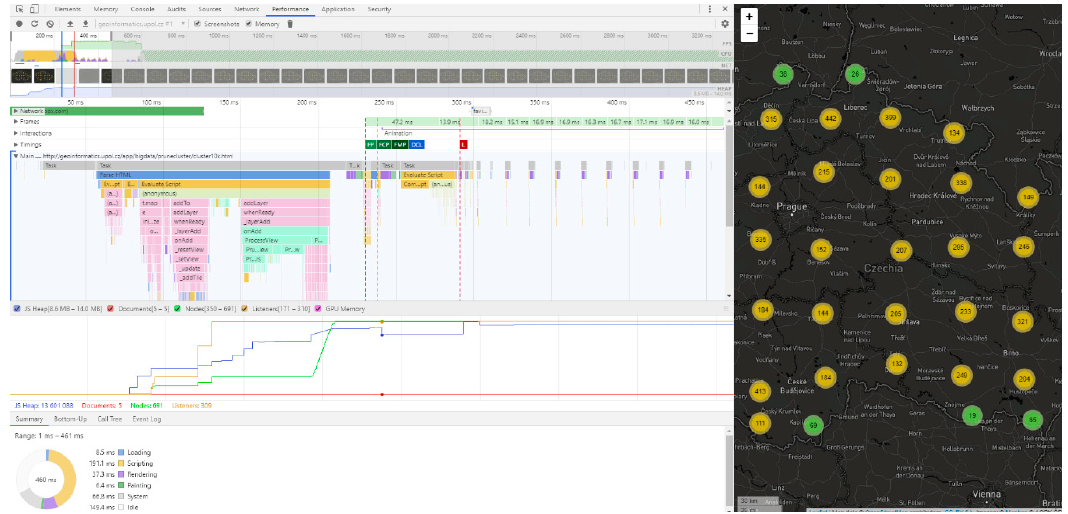
Figure 2. Google Console (developer tools) was used for testing and measuring.